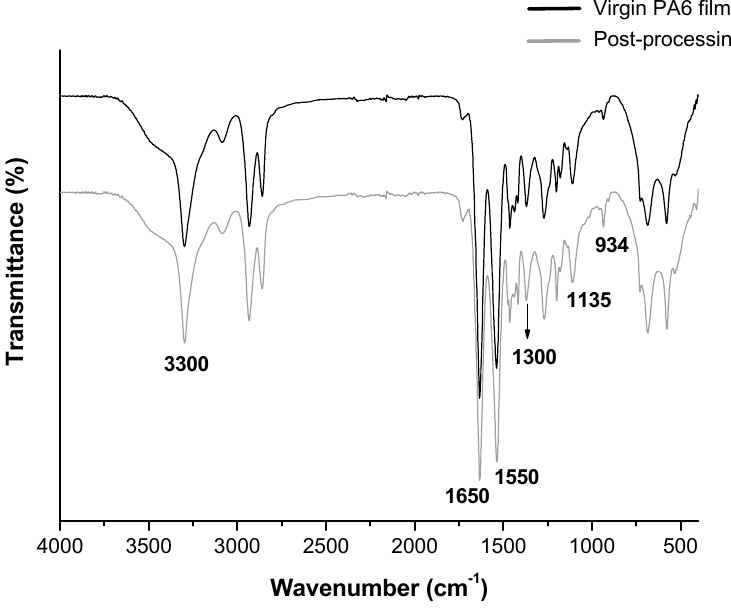
Figure 1. FT-IR spectra of the virgin and post-processing vacuum bags.